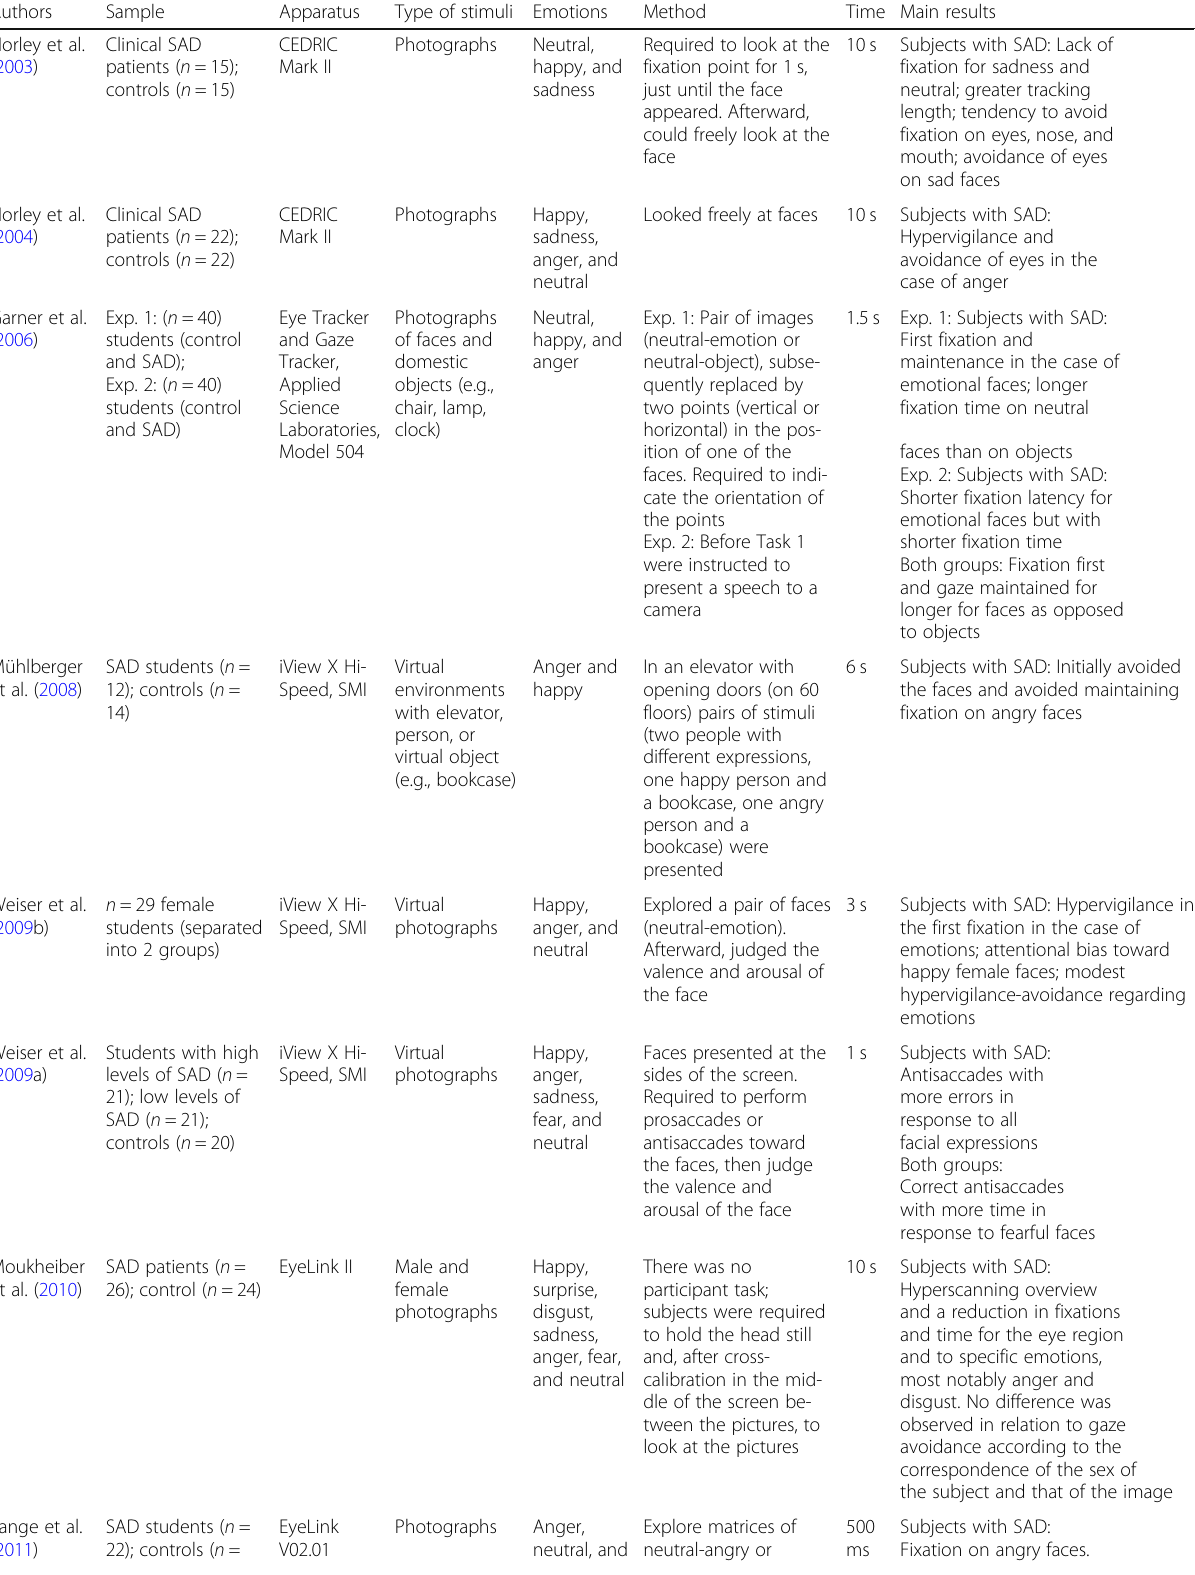
Table 2 Studies selected for the review according to author, sample description, type of stimuli, and emotions